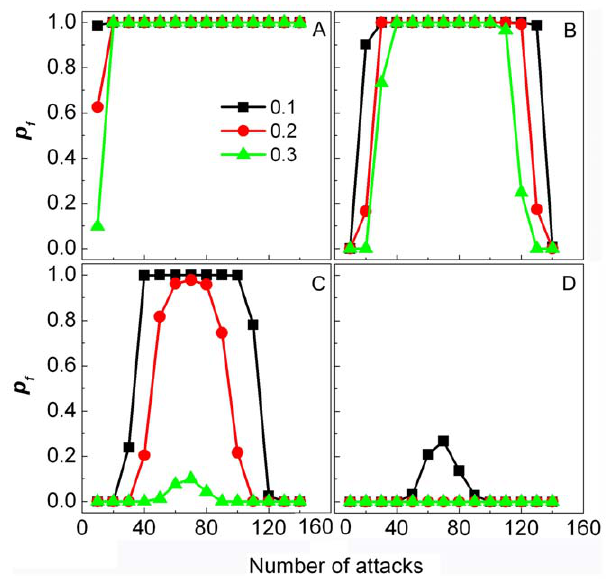
Figure 2. The effects of the intensity of real predatory attacks and population size on the evolution of fearfulness and boldness where a ~ 0 : 1 , 0 : 2 , 0 : 3 . N total ~ 80 ( A ), N total ~ 160 ( B ), N total ~ 240 ( C ), and N total ~ 320 ( D ).